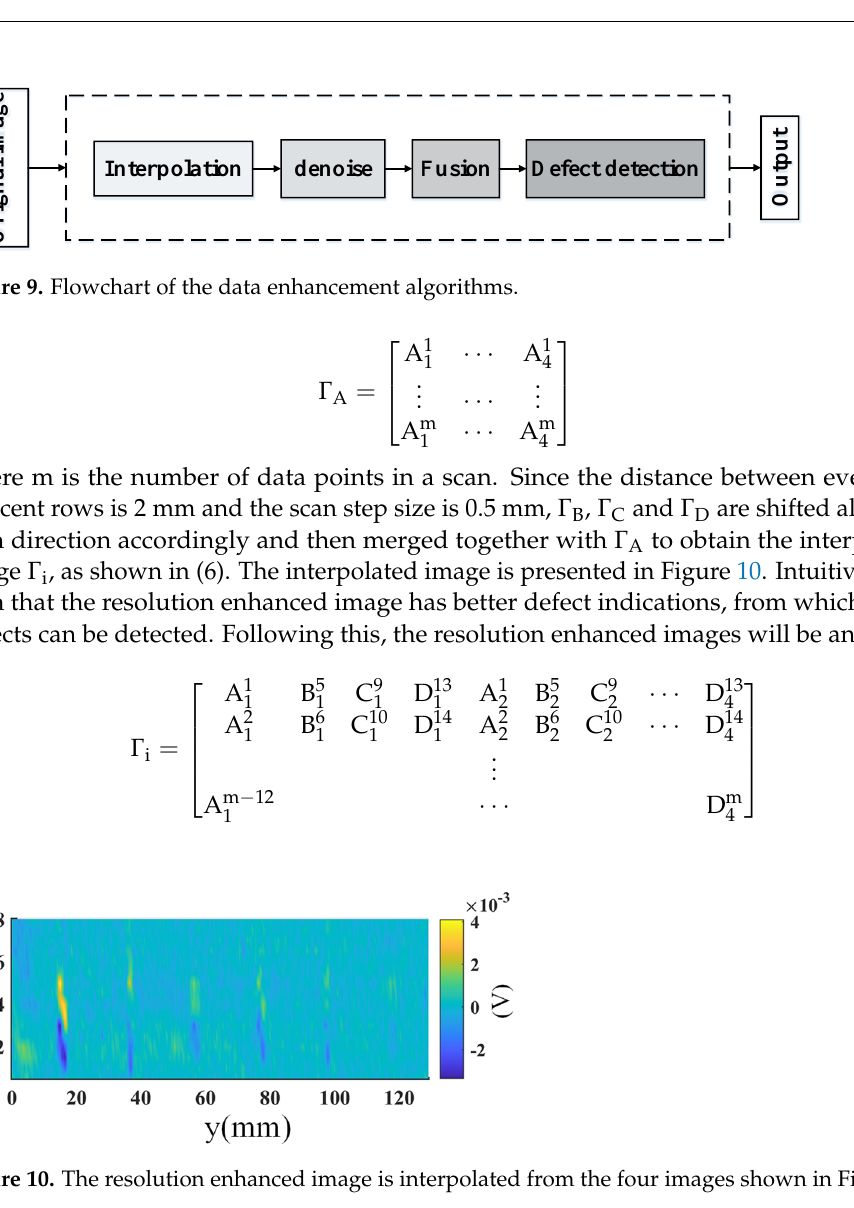
Figure 8. The raw images generated by the four rows of coils with SD excitation: ( a − d ) are the in- phase components of the outputs of the first row to the last row of coils, respectively.